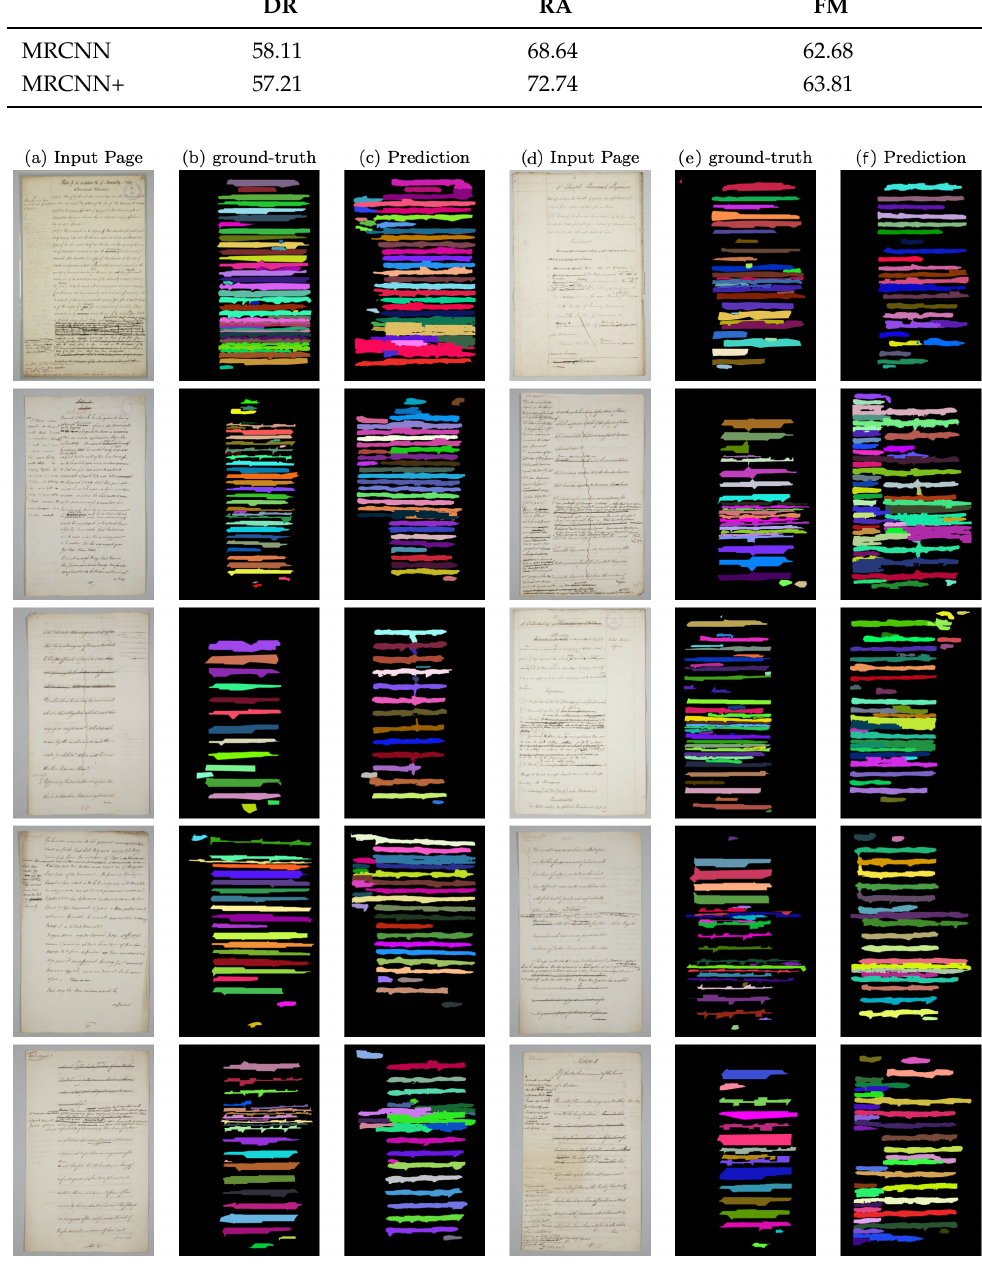
Figure 13. A sample of the segmentation results from ICDAR2015-HTR dataset. Columns ( a , d ) show the input page of the method, columns ( b , e ) show the ground-truth, and cloumns ( c , f ) are the prediction results. Note that the method successfully segments marginal notes which are not present in the ground